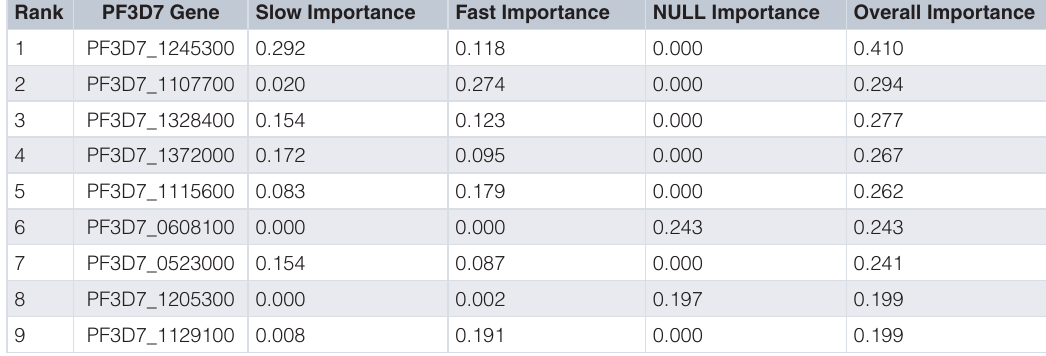
Table 13. Top 10 PF3D7 genes (features) in predicting clearance rate.